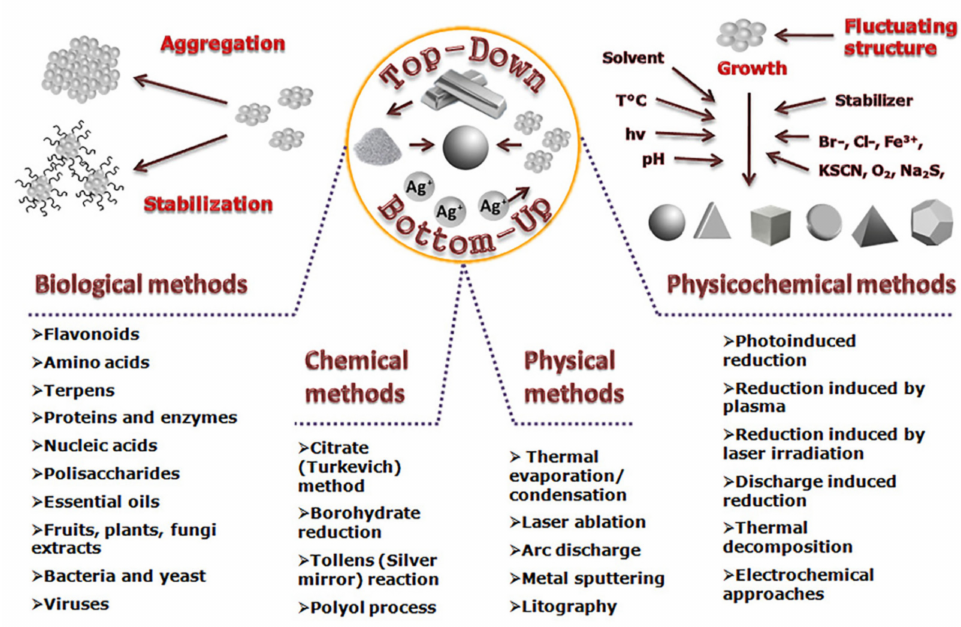
Scheme 1. The synthesis scheme of Ag NPs via various methods GO (adapted with permission from reference